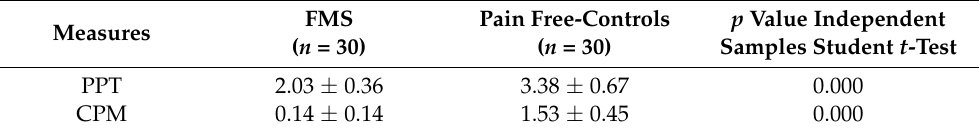
Table 3. Between group comparison of psychophysiological measures. Measures